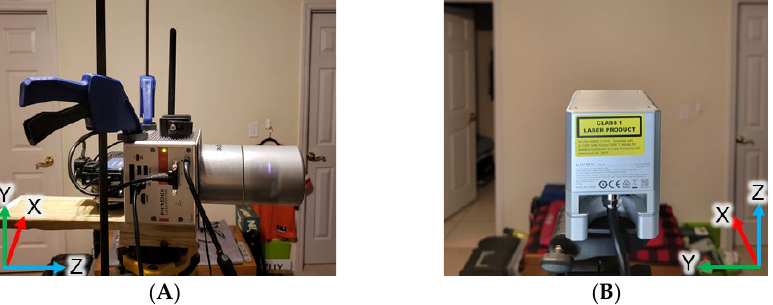
Figure 4. Orientation of ( A ) the Velodyne ® HDL–32E and ( B ) Livox ® Mid–40 during indoor data collection. The scanner orientations shown here were used for all data collection (indoor and outdoor) throughout the duration of this study.